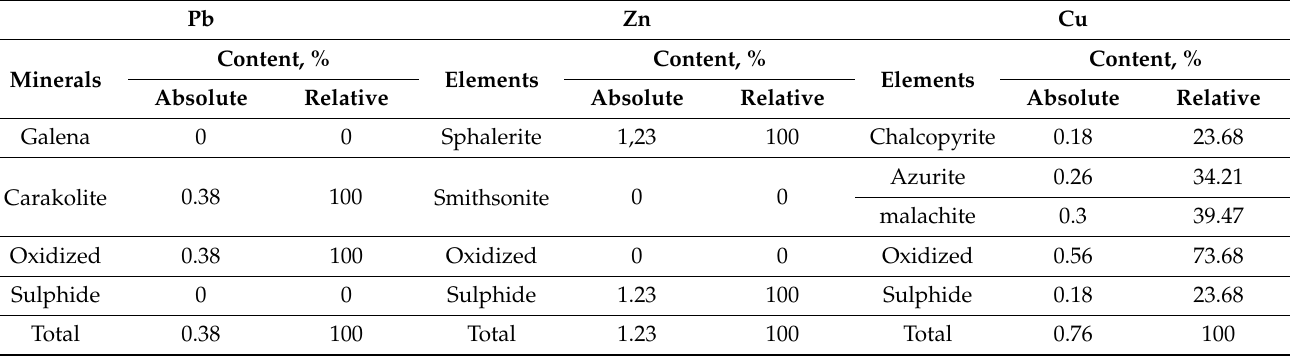
Table 3. The phase composition of the main elements of the enrichment tailings sample.